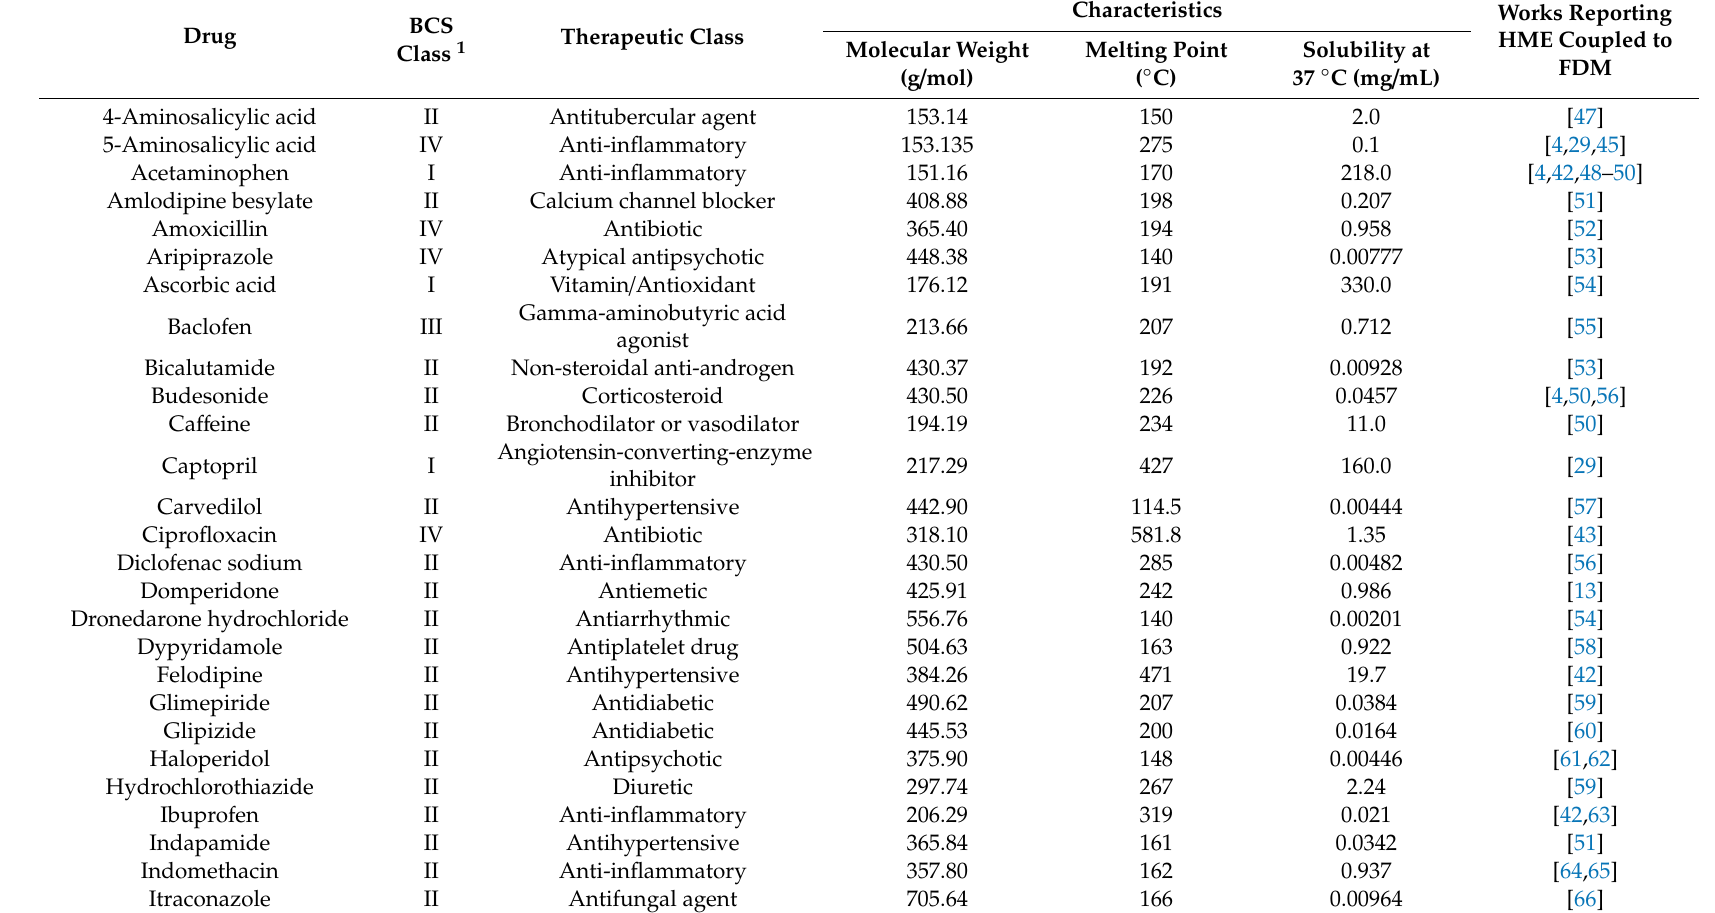
Table 1. Most common drugs used in FDM 3D printing and their